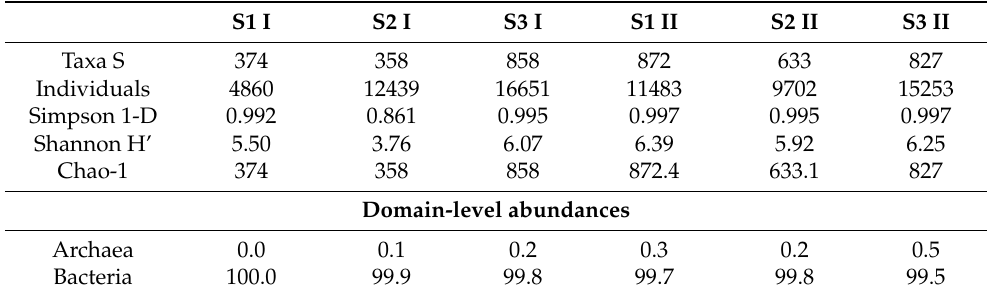
Table 1. Diversity indices calculated on 16s rRNA gene metabarcoding results through PAST 4.03 and abundances (%) at the domain